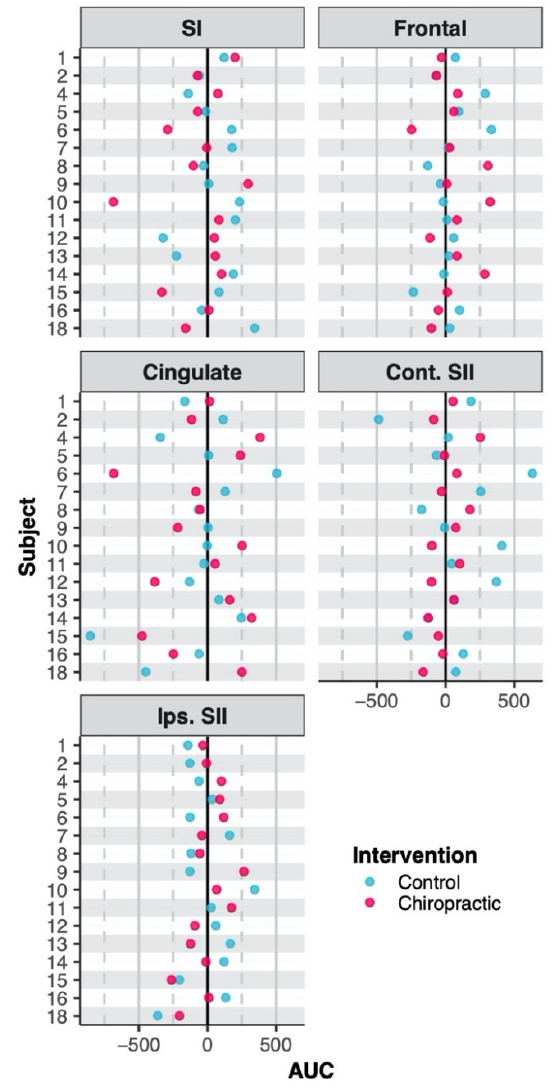
Figure 4. Area under the curve. The dots represent adjusted area under curve (AUC) with respect to the baselines set at 0 (black vertical line) (i.e. post-AUC minus pre-AUC). There were no effects on the strength of brain sources by either intervention. Abbreviations are same as in Table 4.